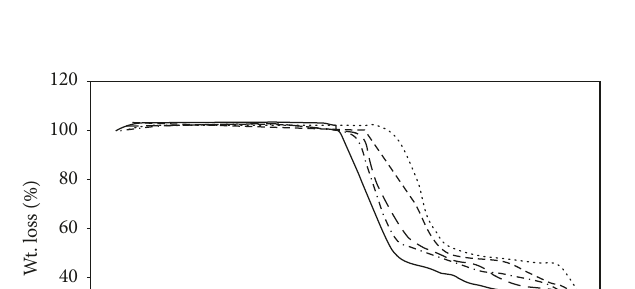
Figure 5: Effect of initiator concentration on the degree of grafting on PVC by N -PhIM. Monomer concentration (3mol/L × 10 − 1 ) at 60 ° C for